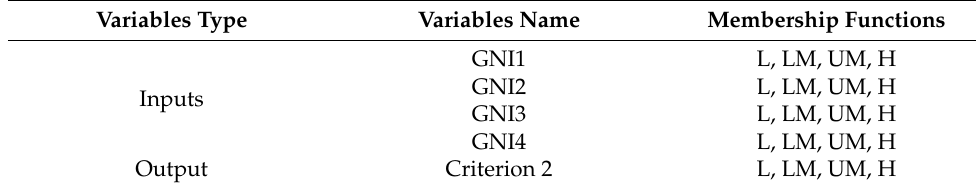
Table 7. Second Type-1 fuzzy system GNI variables.